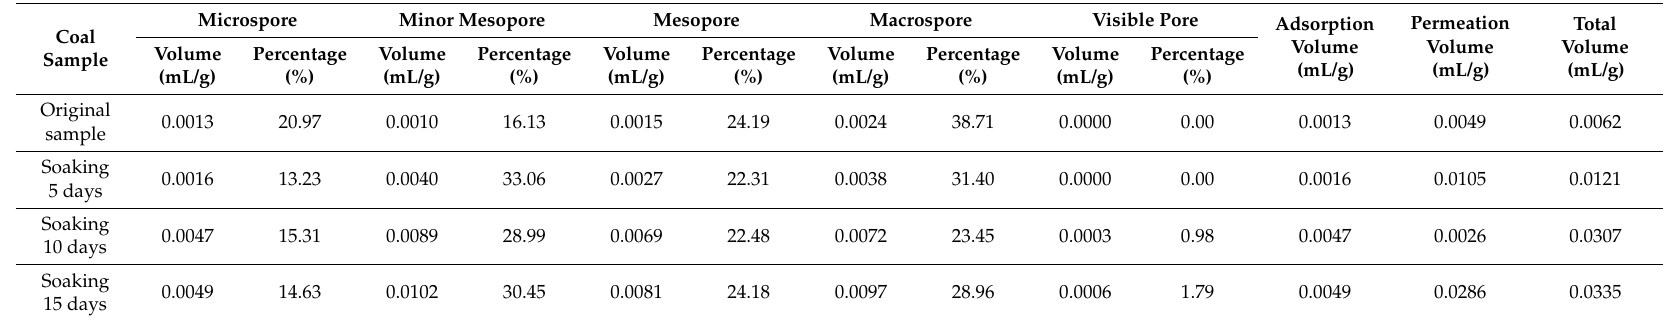
Table 4. The distribution of pore volume of coal samples.